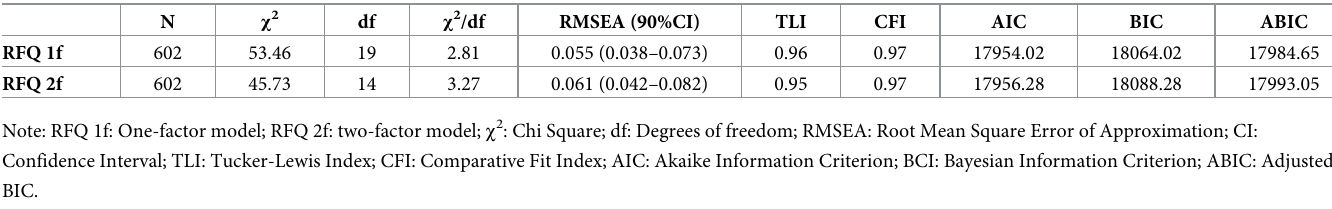
absolute values of the correlation close to 0.4) in the non-clinical sample. On the other hand, the RFQ-8 showed a moderate correlation with the severity of depression, measured by the BDI-II, but only in the clinical sample (Table 4).